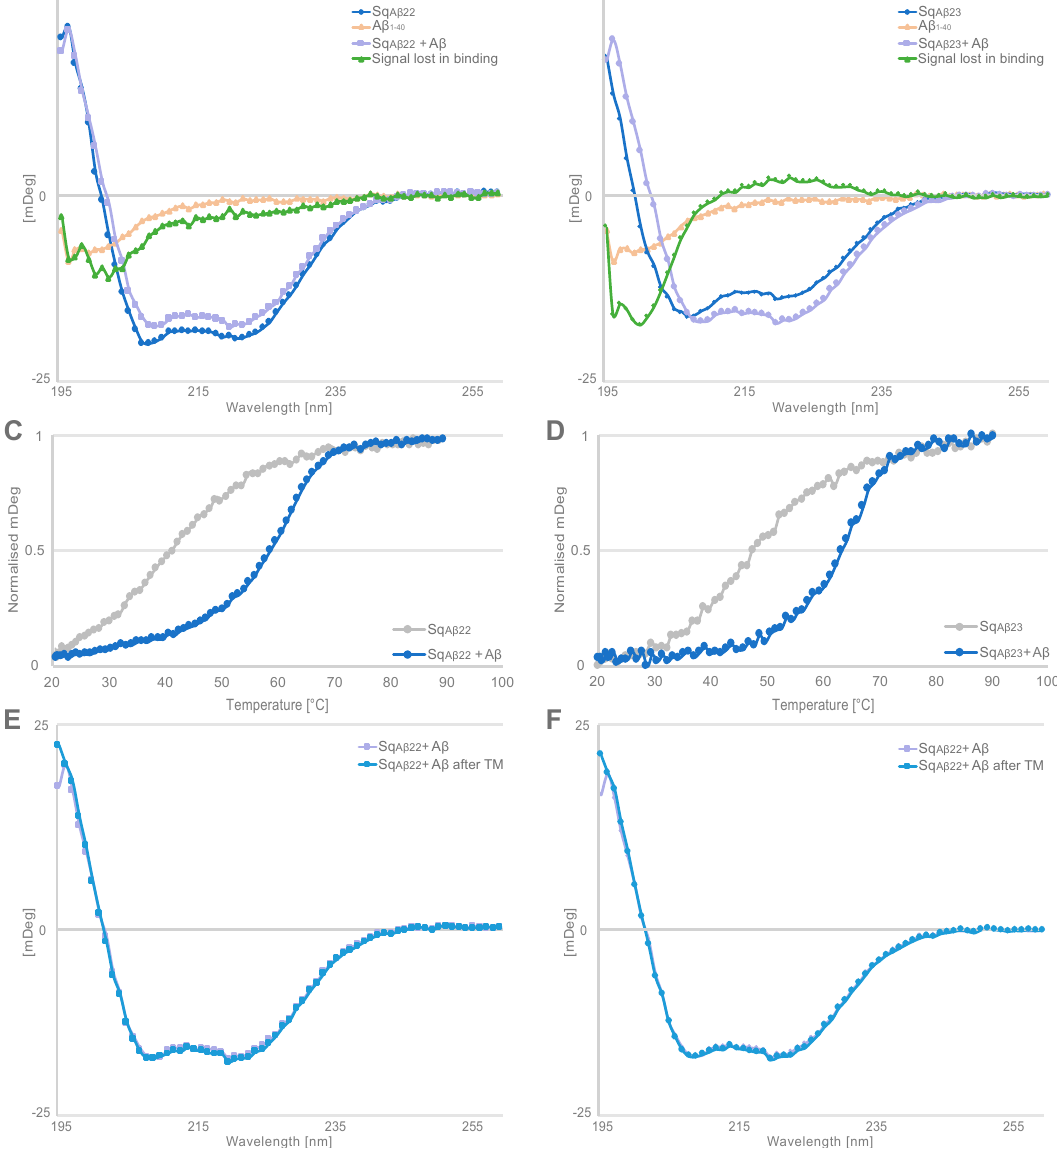
Figure 5. Circular dichroism (CD) spectra between 195–260 nm for proteins in equimolar concentra- tions of 15.7 μ M for ( A , B ) Indicates the structural rearrangement upon co-incubation of peptide and sequestrins (light purple). The green line shows the signal lost upon co-incubation between A β (beige) and the sequestrin (blue). ( C , D ) Variable temperature measurements at 221 nm of Sq A β 22 and Sq A β 23 with and without A β co-incubated with the sequestrins. ( E , F ) Sq A β 22 and Sq A β 23 in complex with A β before (light purple) and after (blue) thermal melting.